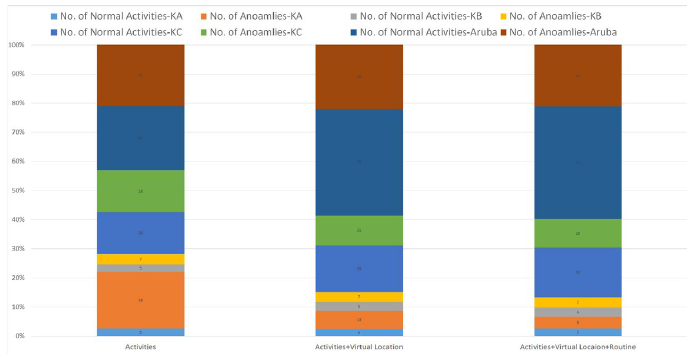
Figure 11. Results of anomaly detection.